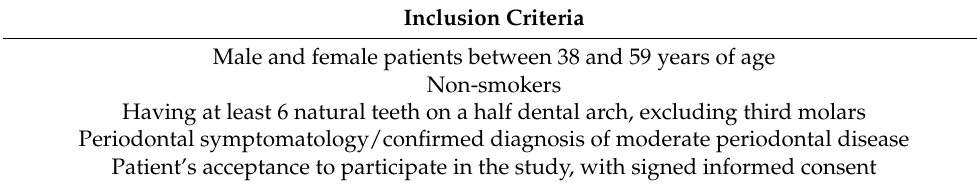
Table 2. Inclusion criteria of patients in